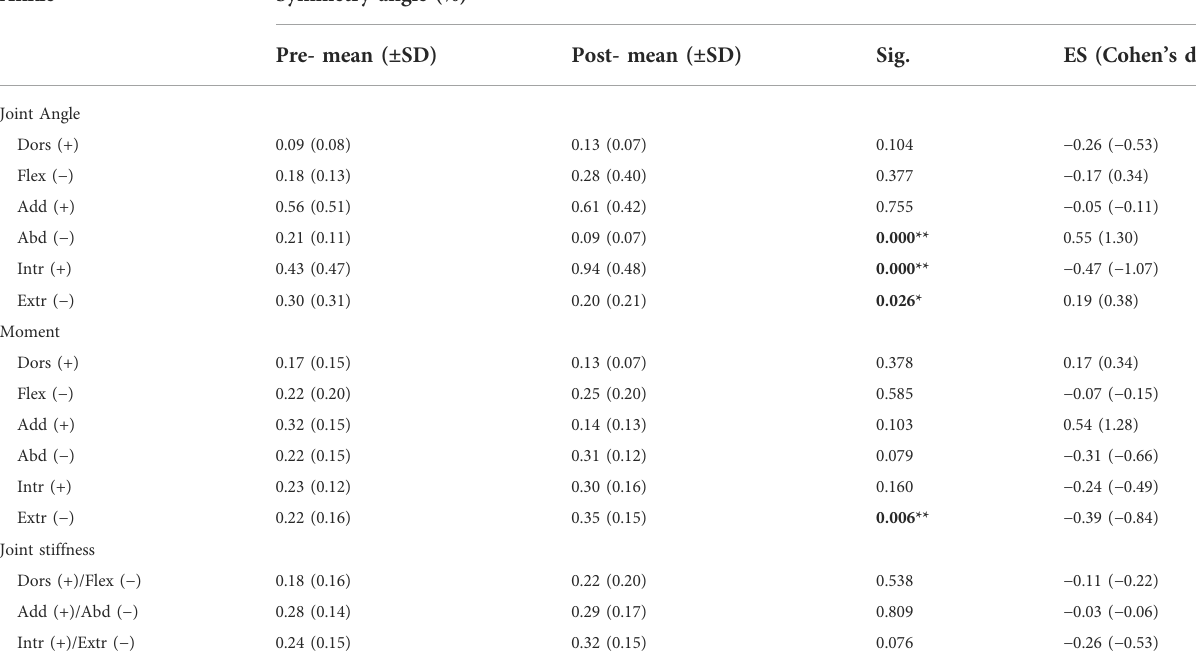
TABLE 2 Changes of ankle joint angle, joint moment, range of motion and joint stiffness symmetry before and after